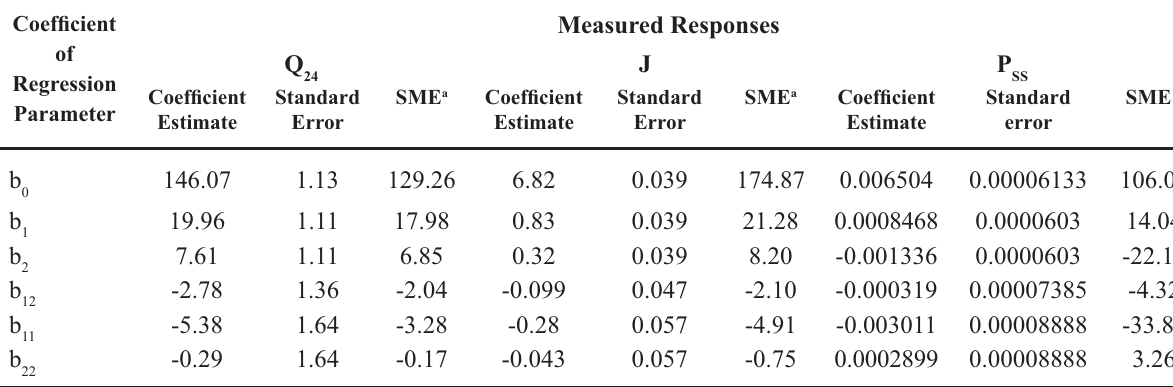
Measured Responses